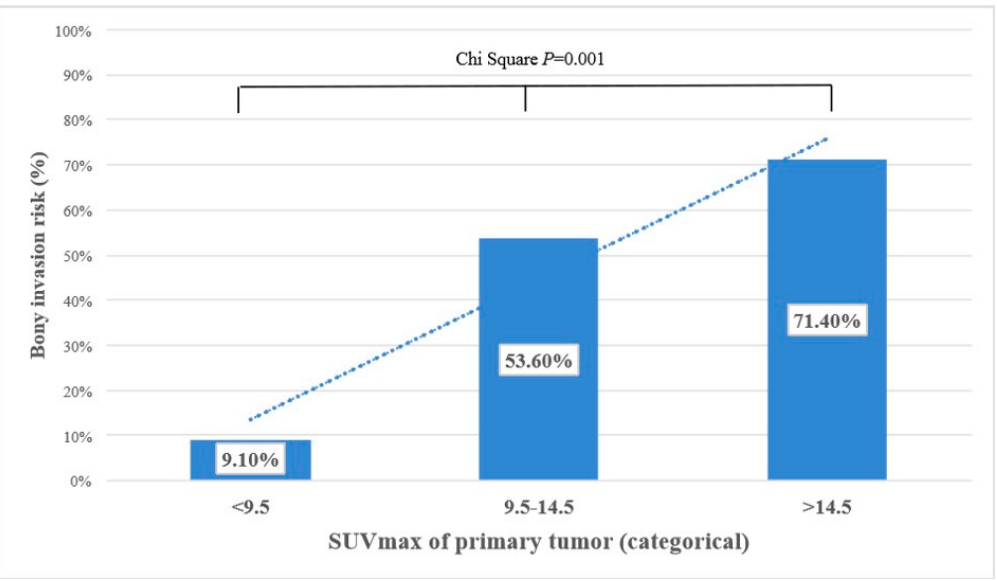
Figure 3. Categorical representation of maximum standardized uptake value (SUV max ) and bone invasion risk. Oral squamous cell carcinoma (OSCC) with low SUV max had a very low risk for bone invasion, while the risk increased in an almost linear manner with increasing SUV max (Pearson chi-squared test, p = 0. 001).